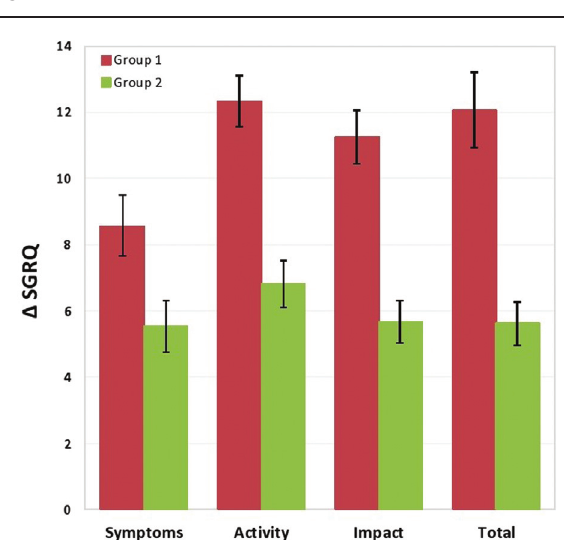
Error bar chart shows comparison between group 1 and group 2 regarding Δ SGRQ; par represents mean and Y-error bar represents 95% confidence interval of mean. SGRQ, Saint George respiratory